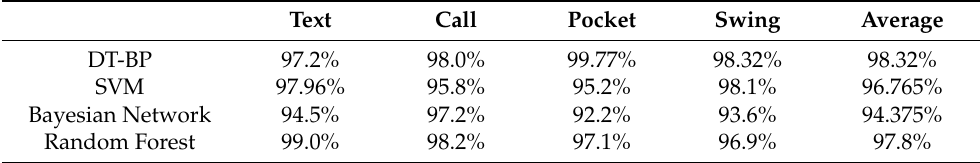
Table 10. Comparison of smartphone mode recognition accuracy for different methods.